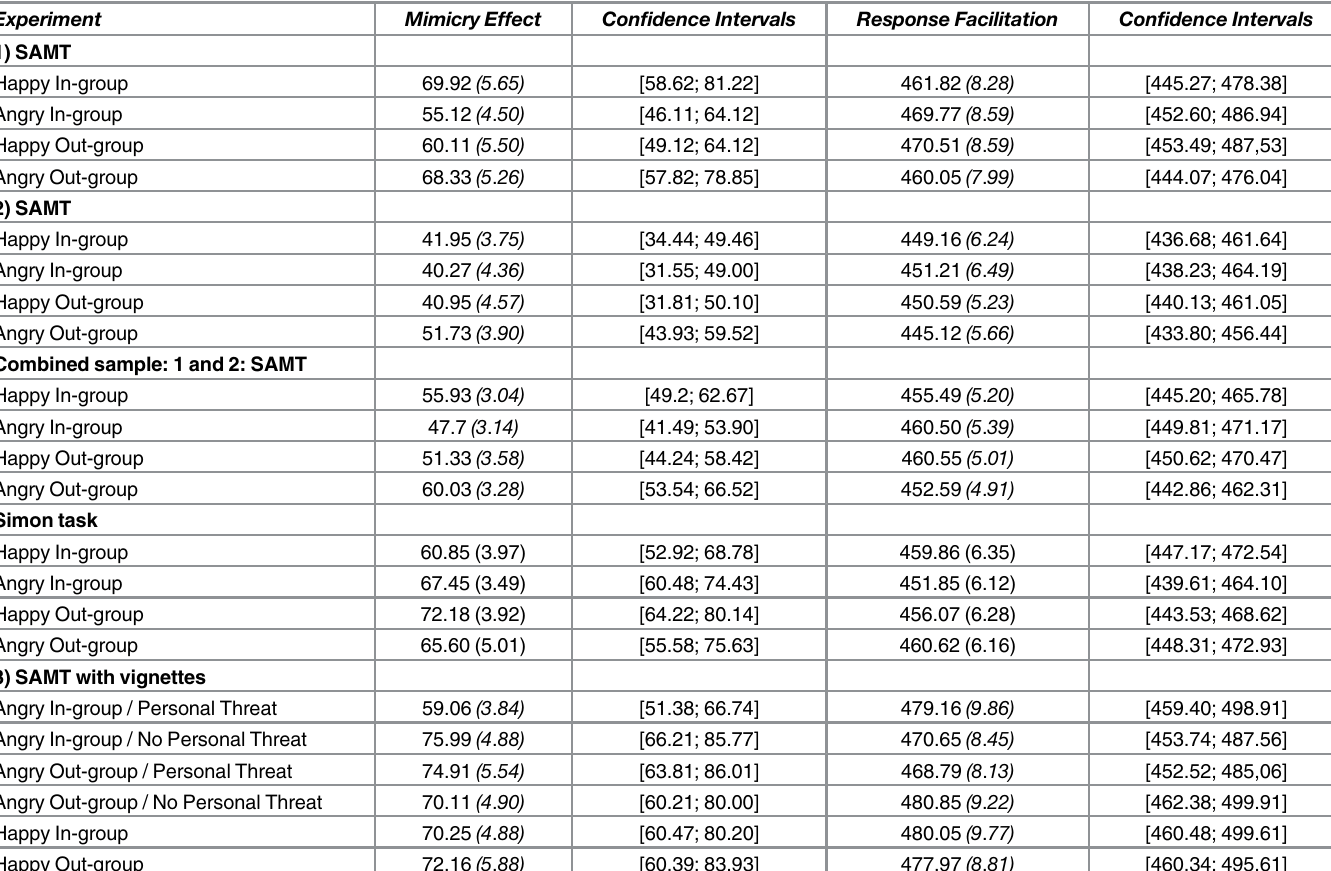
Table 1. Results mimicry effect (difference measure mean RT incongruent minus congruent trials) and response facilitation (mean RT on congru- ent trials) with corresponding confidence intervals in the SAMT across all three experiments and the pooled samples of Experiment 1 and 2, as well as the Simon-task in Experiment 2, in ms; italic numbers referring to standard error of the mean (SE) .